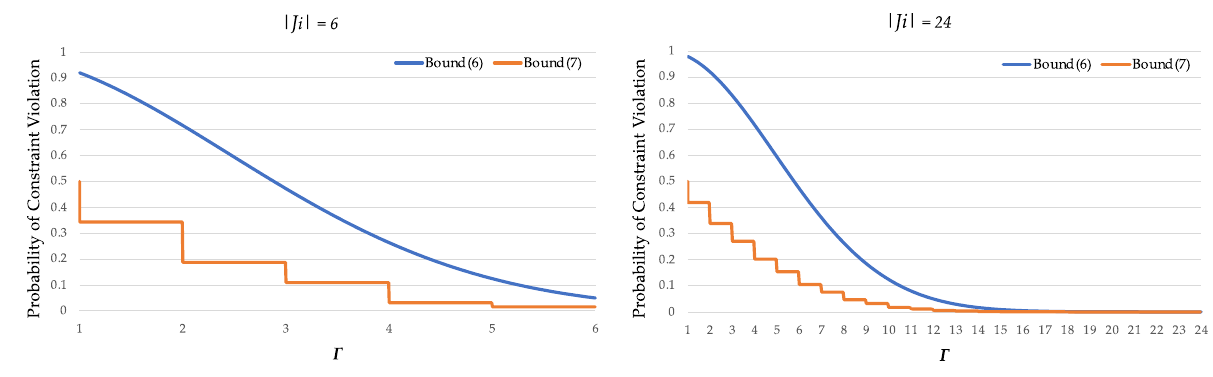
Figure 2. Comparison of probability Figure 2 . Comparison of probability bounds.